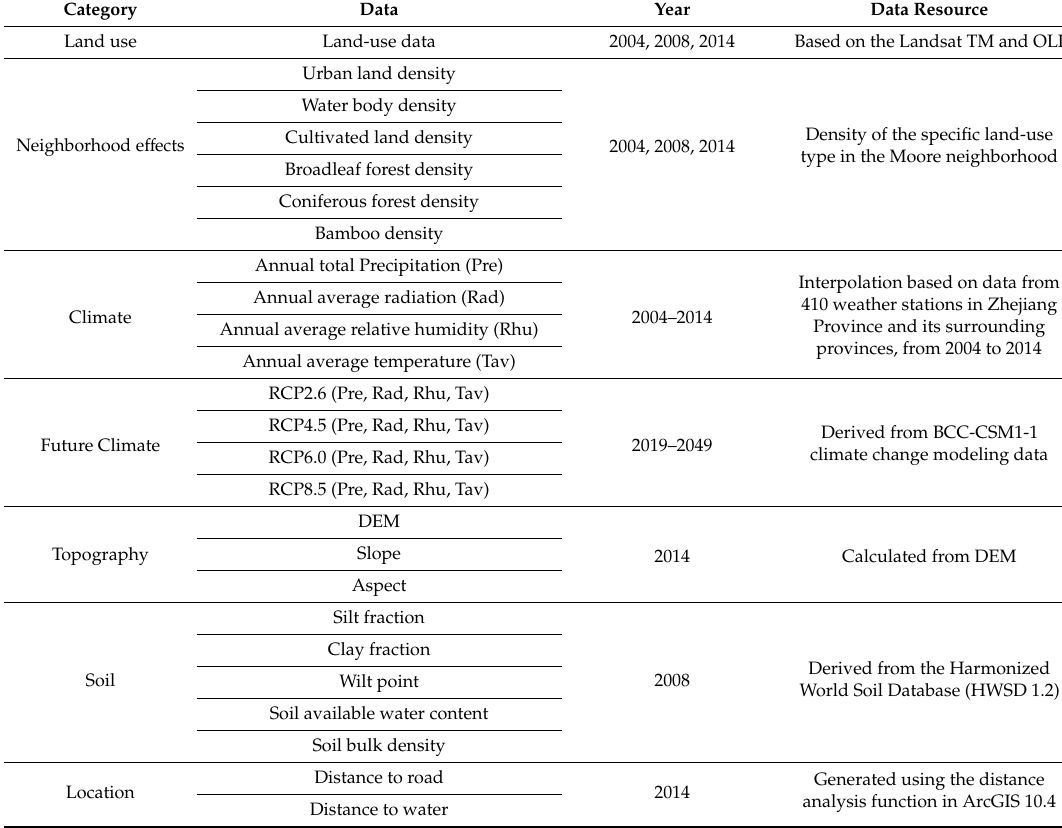
Table 1. List of data used in this